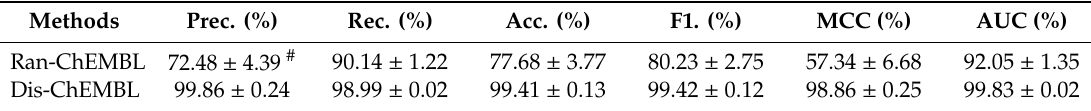
# The value in the table means average value ± standard